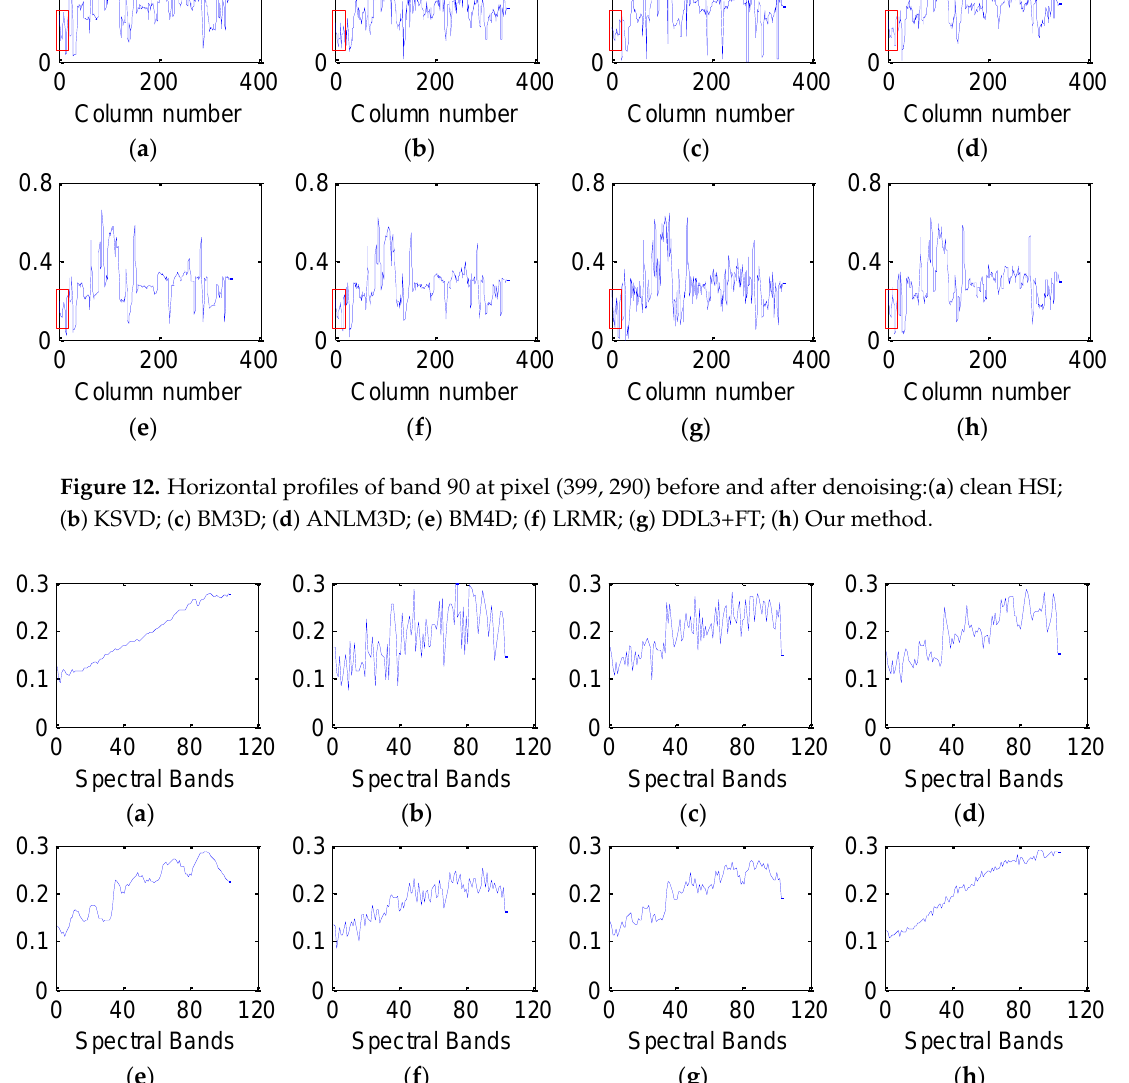
Figure 12. Horizontal profiles of band 90 at pixel (399, 290) before and after denoising:( a ) clean HSI; ( b ) KSVD; ( c ) BM3D; ( d ) ANLM3D; ( e ) BM4D; ( f ) LRMR; ( g ) DDL3+FT; ( h ) Our method.